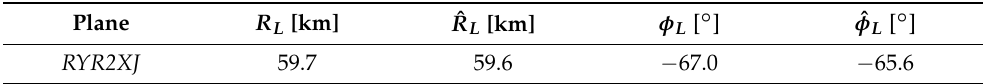
Table 4. Distance and azimuth of the RYR2XJ plane’s location in relation to the LOFAR station.